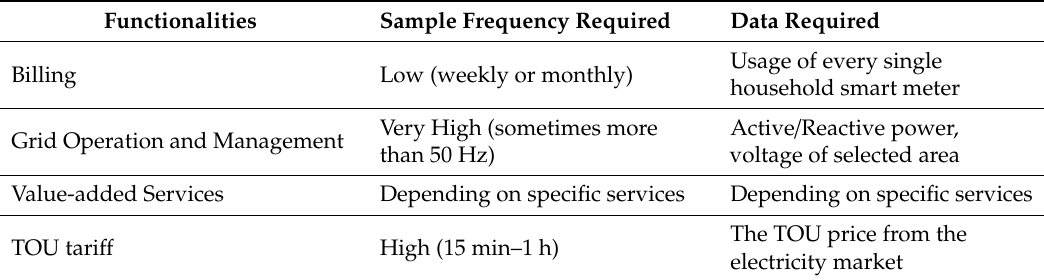
Table 1. Summary of data granularity of different functionalities.